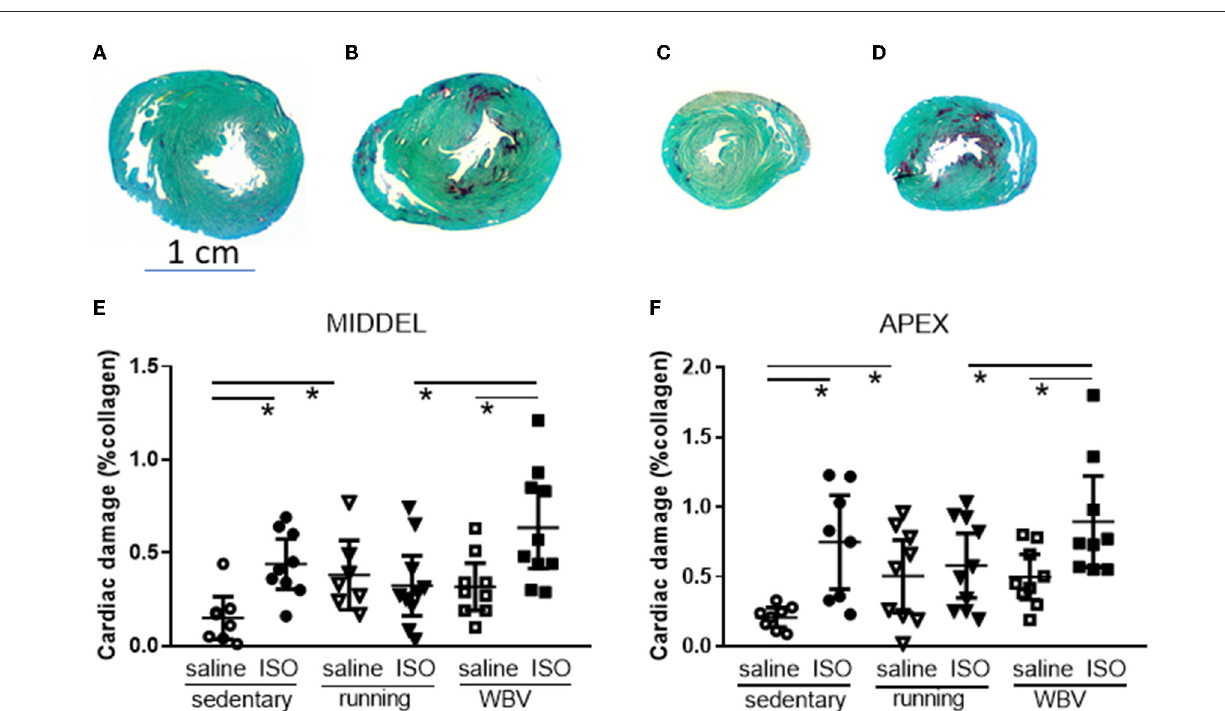
FIGURE3 Presentation of midventricular and apex sections stained for Sirius red (red) and Fast green (green), from sedentary saline [ (A, C) , respectively] and isoproterenol whole-body vibration-treated rats [ (B, D) , respectively], showing increased Sirius red positive areas after ISO treatment. Lower panels: actual measurements of the percentage of collagen in the left ventricle as Sirius Red positive area at mid-ventricular (E) and apex level (F) , in saline or isoproterenol (ISO)-treated rats, under sedentary conditions, or after 5 weeks of exercise training (running) or whole-body vibration (vibration). *Significant difference between indicated groups ( p <